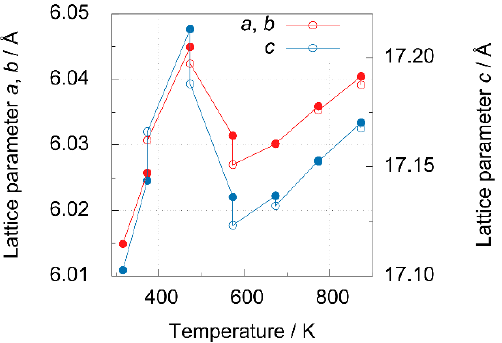
Figure 4. Lattice parameters a , b , and c of Ba 2 In 1.8 Cr 0.2 O 5.3 (H 2 O) x determined by Rietveld refinements based on neutron diffraction data; filled points represent the first measurement, and open points the second measurement at the target temperature, ± σ within dot size. The measurements were taken in dynamic vacuum ( p min ≥ 1 × 10 − 3 mbar).